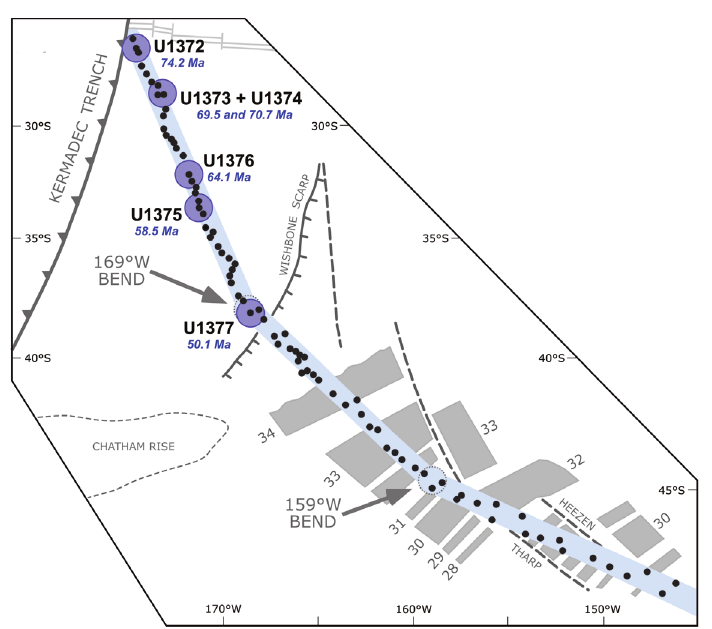
Figure 1. The Louisville seamount trail is defined by a narrow 75-km-wide chain of guyots and seamounts. The five guyots drilled during IODP Exp. 330 are indicated by purple circles. Also indicated are the Wishbone Scarp, which marks the easternmost boundary of the Exp. 330 drill sites and a likely sudden transition in age and thickness of the Pacific ocean crust, and the 169°W bend, which is equivalent (but less pronounced and slightly older in age; Koppers et al., 2011) to the distinctive 120 ° bend in the Hawaiian-Emperor seamount trail. Figure after Koppers et al.